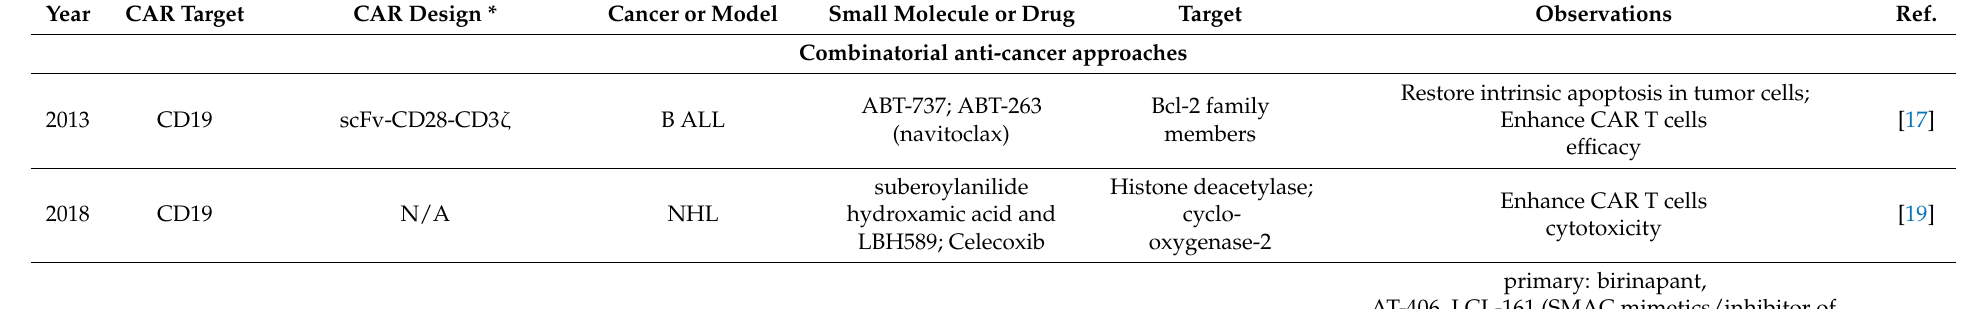
Table 1. Selected studies combining CAR T cells and small molecules or